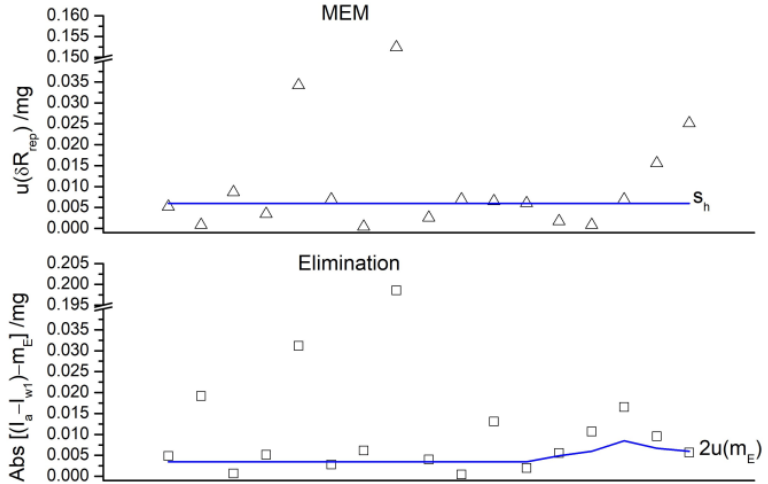
Figure 17. Checking results .